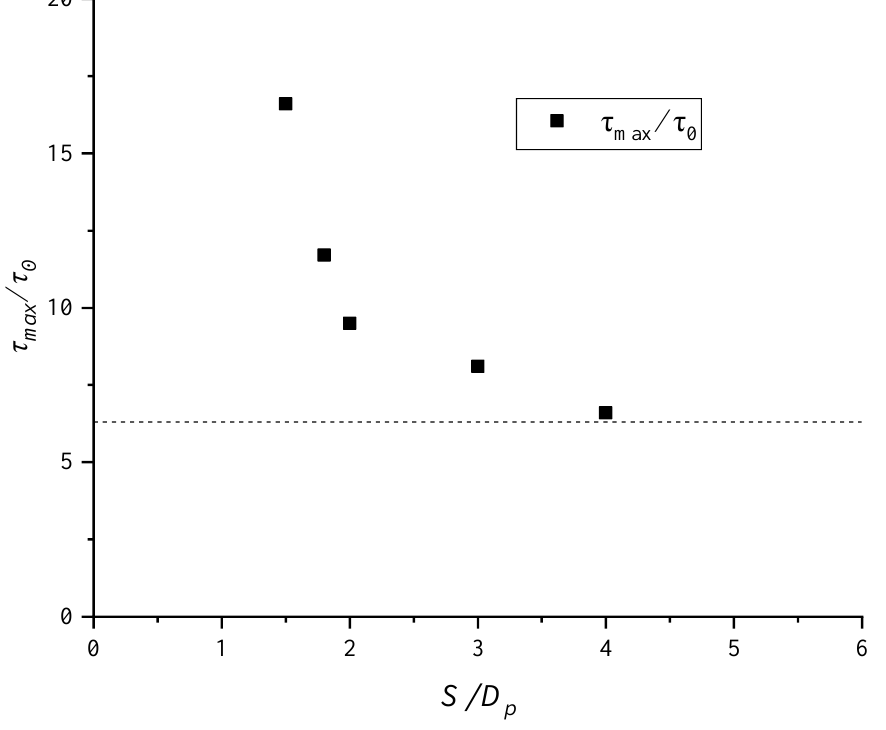
Figure 8. 𝜏 𝑚𝑎𝑥 𝜏 0 ⁄ changes with 𝑆 𝐷 𝑝 ⁄ of the present work; dashed line denotes 𝜏 𝑚𝑎𝑥 𝜏 0 ⁄ in Case 6 Figure 8. τ max / τ 0 changes with S / D p of the present work; dashed line denotes τ max / τ 0 in Case 6 (single pile). (single